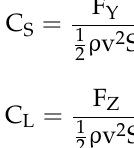
Figure 10. Pressure distribution for different height schemes (( a ) Bare bridge; ( b ) Scheme 2-1; ( c ) Scheme 2-2; ( d ) Scheme 2-3).